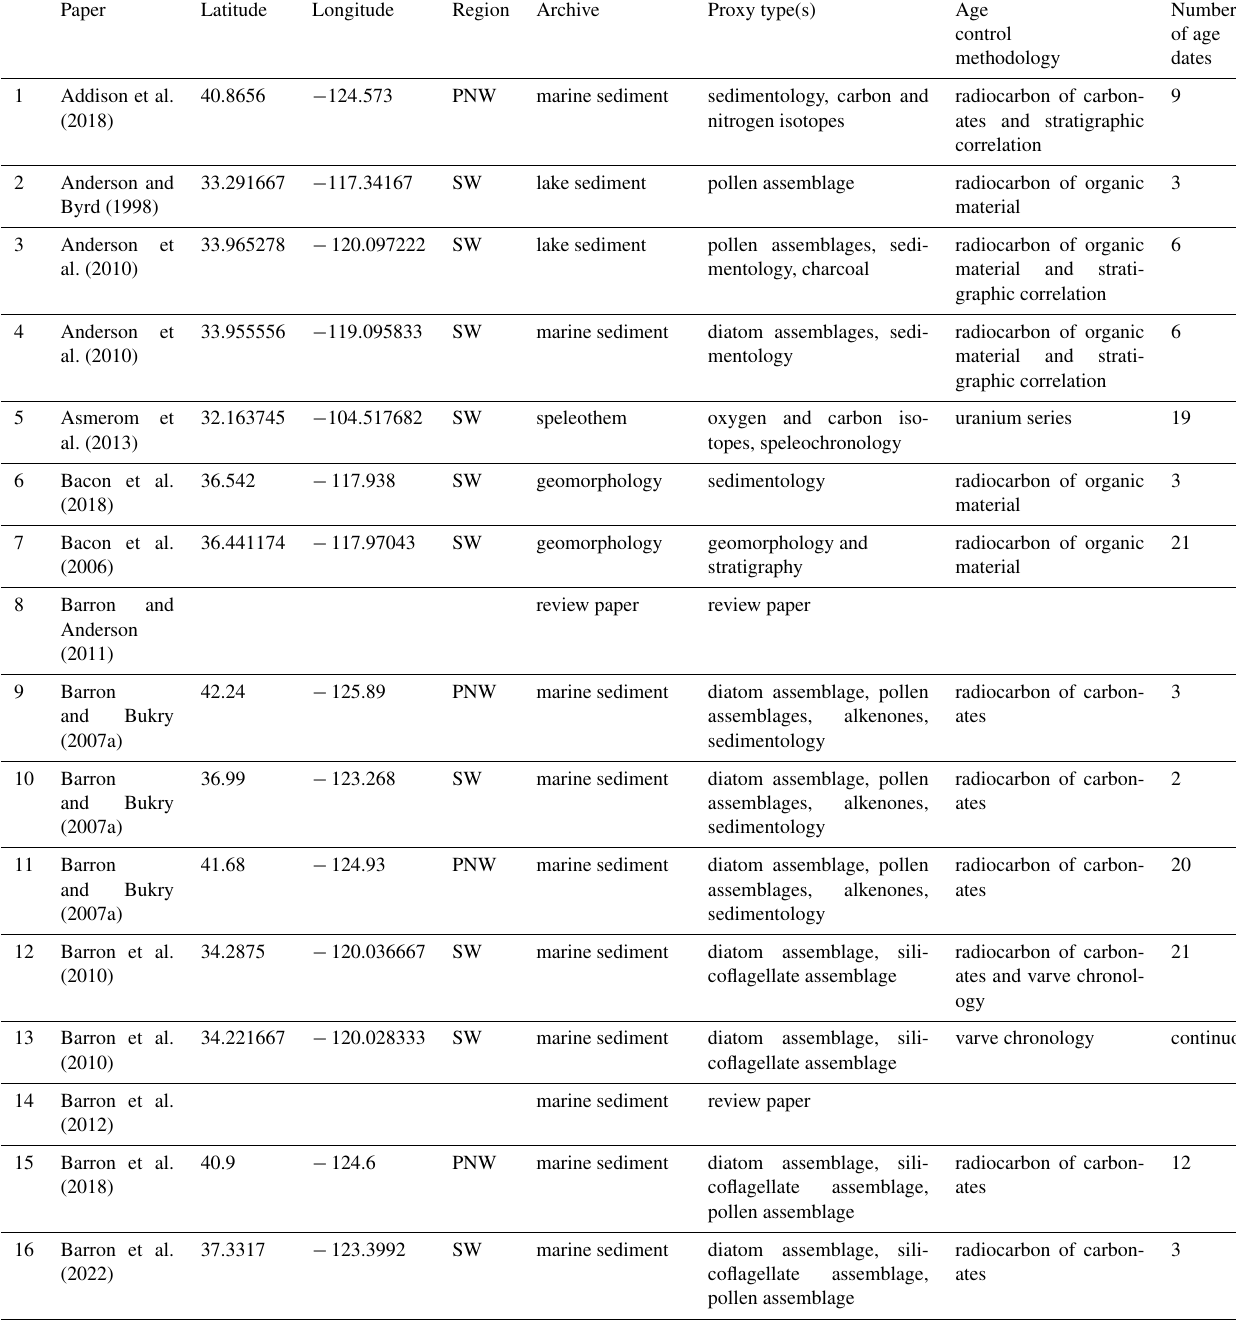
Table B1. Appendix B contains a list of papers used in the literature review and the coded spatiotemporal analysis. Abbreviations are as follows: Southwest – SW, Pacific Northwest –